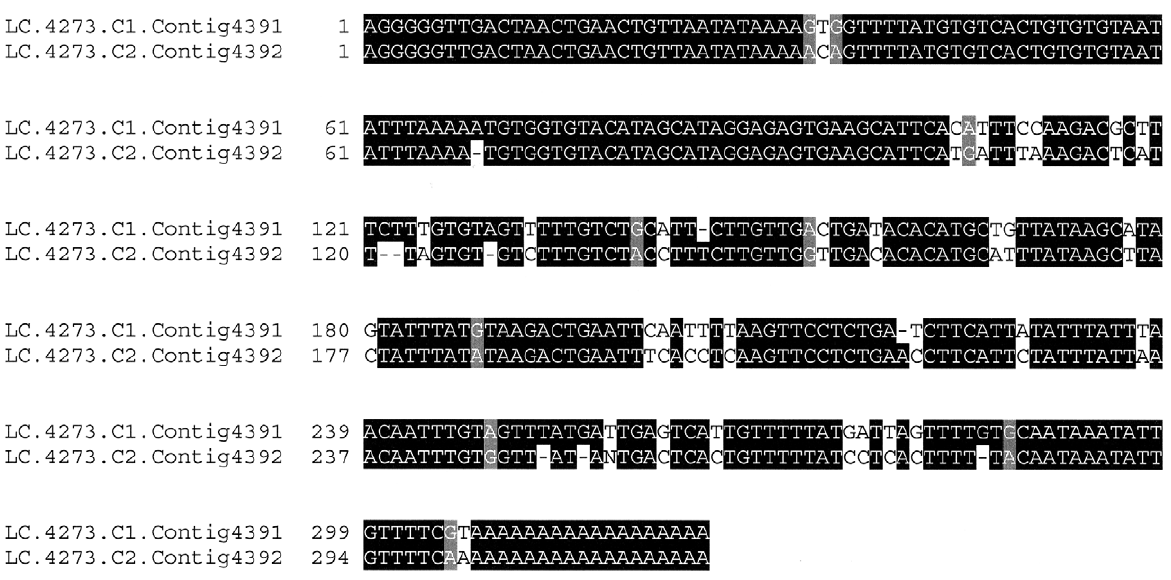
Figure 3. Pairwise alignment of the sequences corresponding to LC.4273.C1.Contig4391 and LC.4273.C2.Contig4392. The alignment was performed in ClustalW2 software [92;93] (input sequences were defined as DNA, other parameters were set at default values). Conserved residues are highlighted in black. Purine transition mutations are shaded.